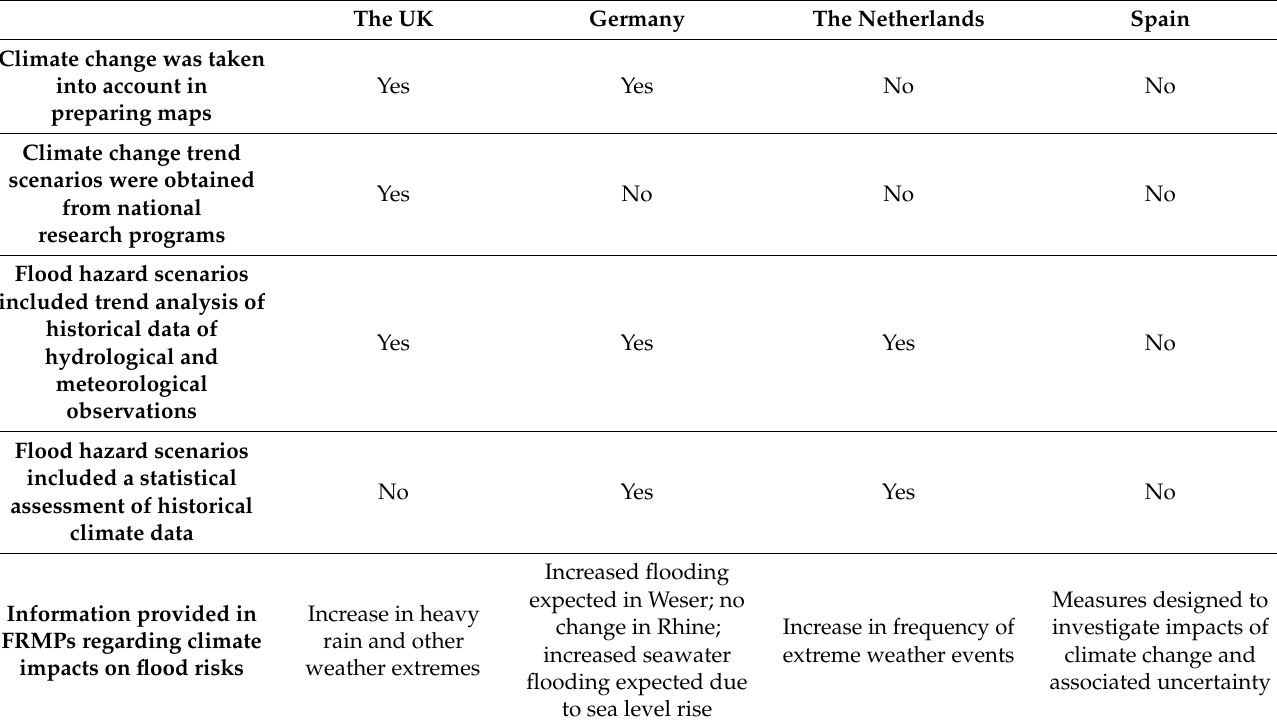
Table 2. Summary of how climate change is included in the first cycle of FD implementation. Own elaboration based on documents: “ EU Overview of Methodologies Used in the Preparation of Flood Hazard and Flood Risk Maps “ [55] and “ EU